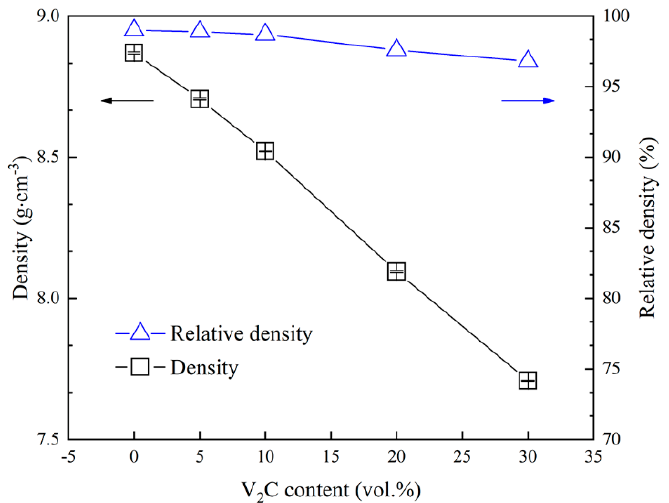
Figure 5. Density of Cu composites as a function of V 2 C content.